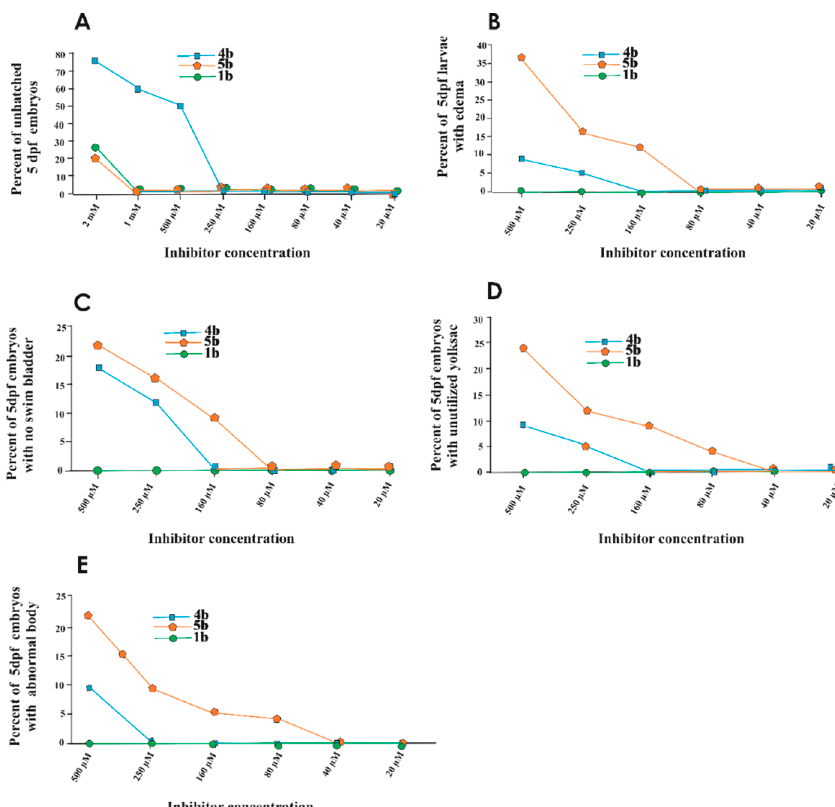
Figure 5. Effect of the prodrugs 4b , 5b , and 1b on the phenotypic parameters of zebrafish larvae. The plot graphs show the phenotypic abnormalities in the zebrafish larvae after 5 days of exposure to compounds. ( A ) Hatching, ( B ) edema, ( C ) swim bladder development, ( D ) yolk sac utilization and ( E ) body shape for each concentration (N = 72).